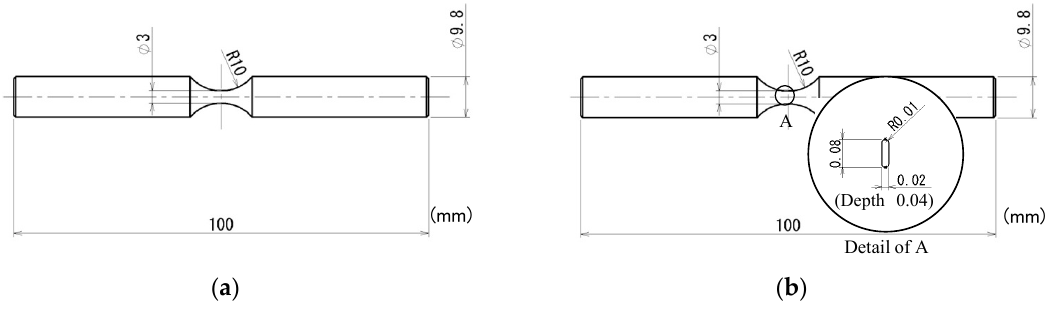
Figure 3. Specimens used for S - N curve and investigating the fatigue crack growth (FCG) rate of short surface cracks at a stress ratio of R = − 1: ( a ) Plane specimen (un-notched specimen) for determination of S - N curve; ( b ) Notched specimen for investigating the FCG rate of short surface cracks.